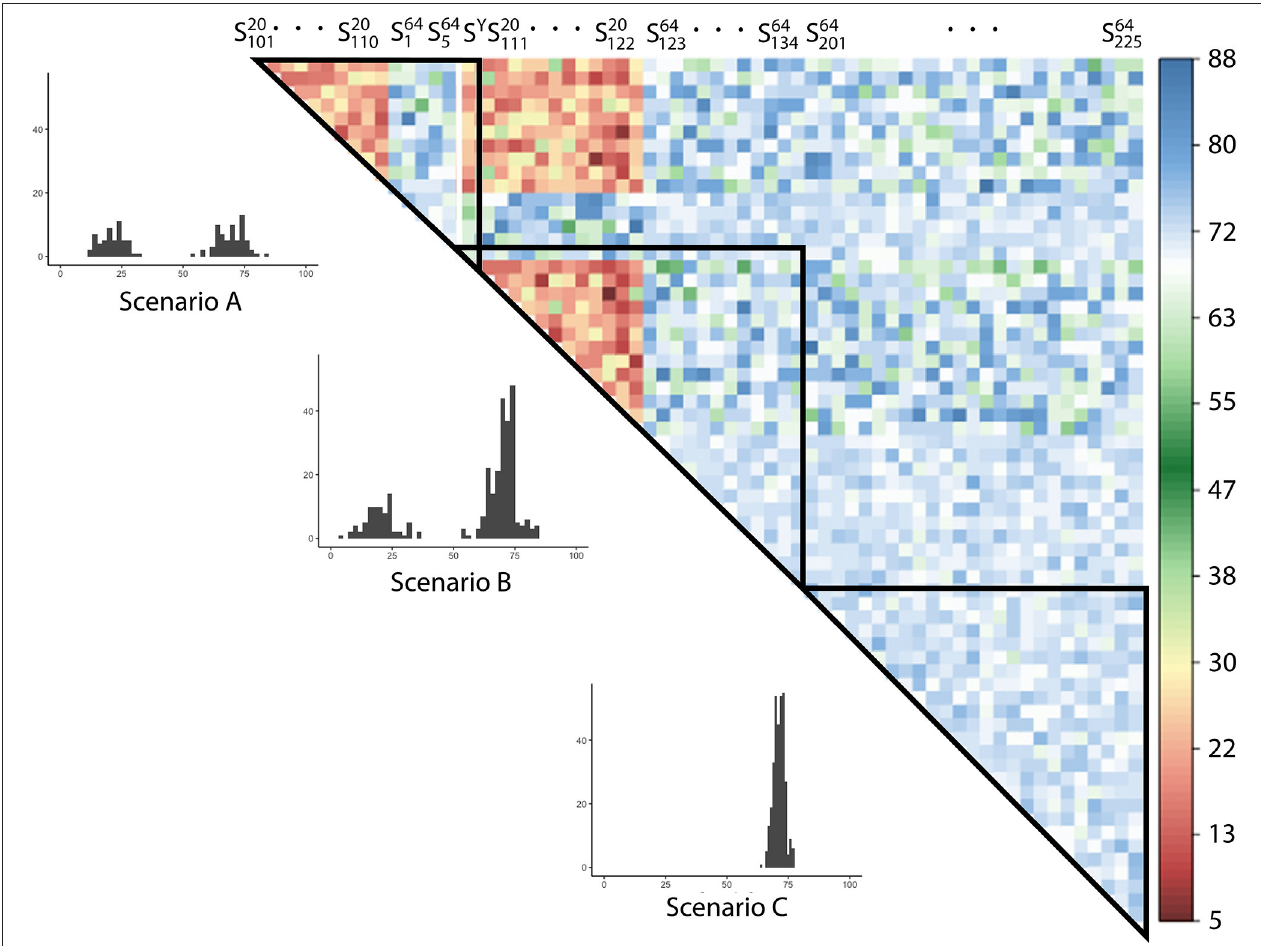
FIGURE 5 | The number of SDS linguistic items overlapping across balanced random subsets. Group-internal overlaps belonging to Scenarios A–C (introduced in section 4.3.2, below) are highlighted in triangles. The histograms show the amounts of overlap for the three scenarios.